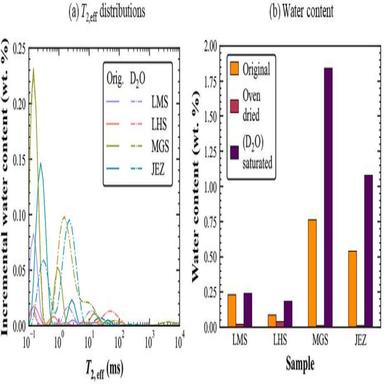
Comparison of NMR relaxometry measurements of "dry samples". (a) T2eff distributions for (i) the original dry sample, and (ii) the D2O saturated sample. (b) Total water content values determined via NMR relaxometry for (i) the original dry sample, (ii) the oven dried sample, and (iii) the D2O saturated sample. These measurements are determined for the four regolith simulants: Lunar mare (LMS), Lunar highlands (LHS), Mars global (MGS) and Jezero delta (JEZ).